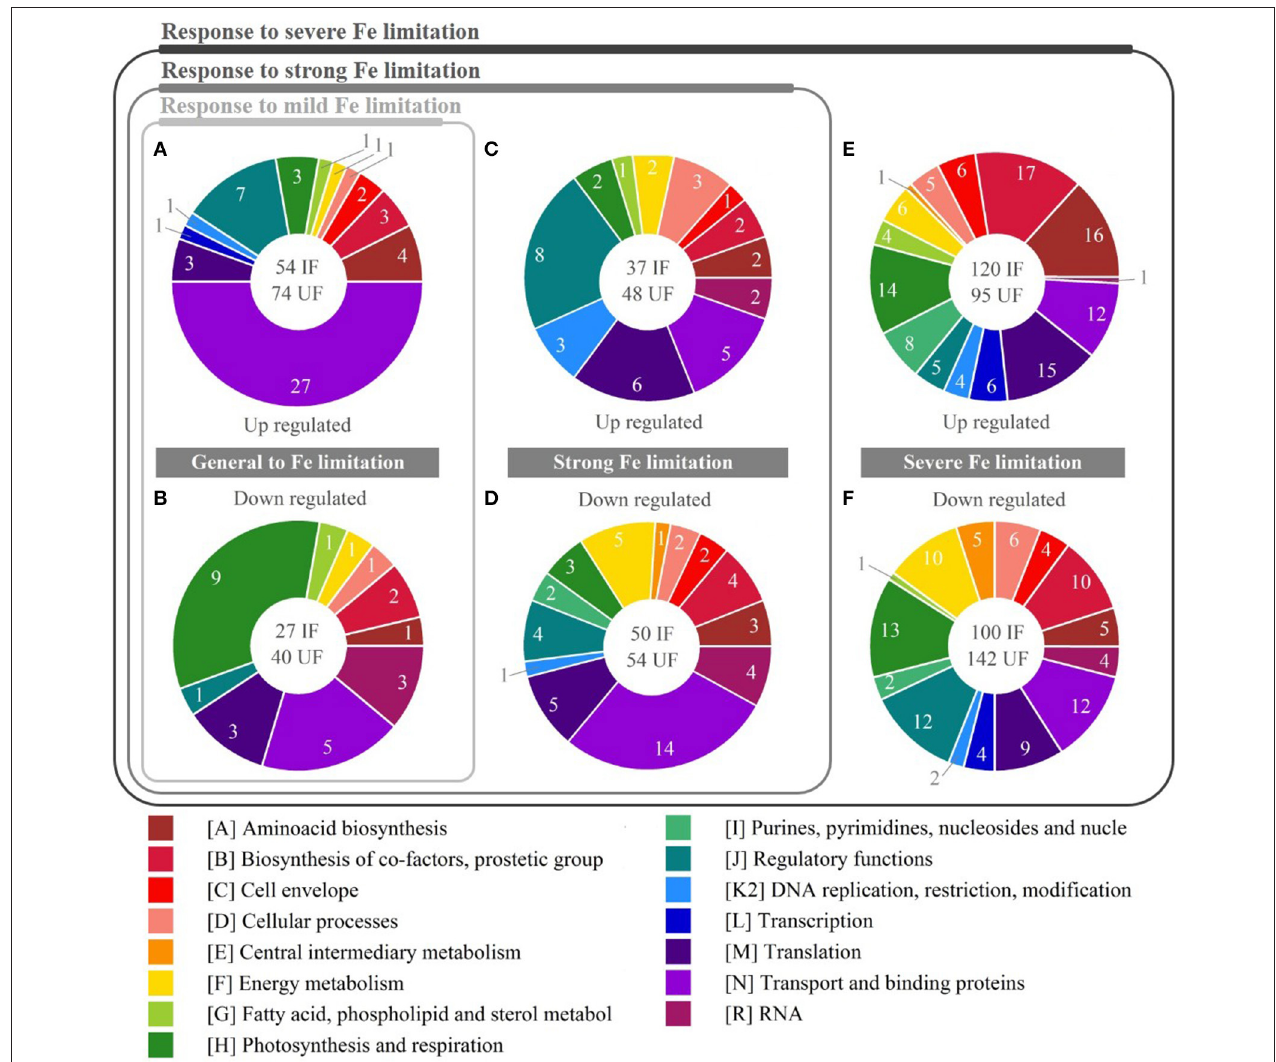
FIGURE 5 | Functional categories regulated in response to iron (Fe) limitation. Pie charts show relative amount of DEG for three levels of response to Fe limitation. In the white circle: IF indicates the amount of differentially expressed genes (DEG) with identified function; UF (not considered in the chart) the amount of DEG with unidentified function. Pies (A,B) represent the up-regulated and down-regulated genes, respectively, in response to mild Fe limitation. Pies (C,D) represent the up-regulated and down-regulated genes, respectively, in response to strong Fe limitation. Pies (E,F) represent the up-regulated and down-regulated genes, respectively, in response to severe Fe